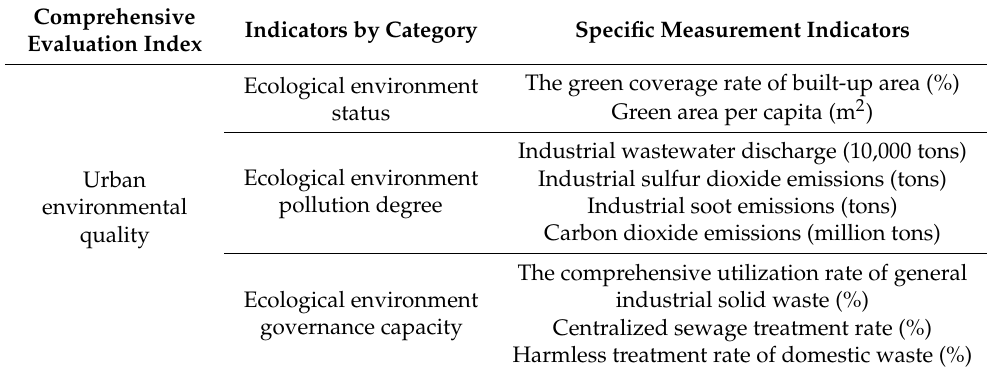
Table 1. Urban environmental quality measurement index